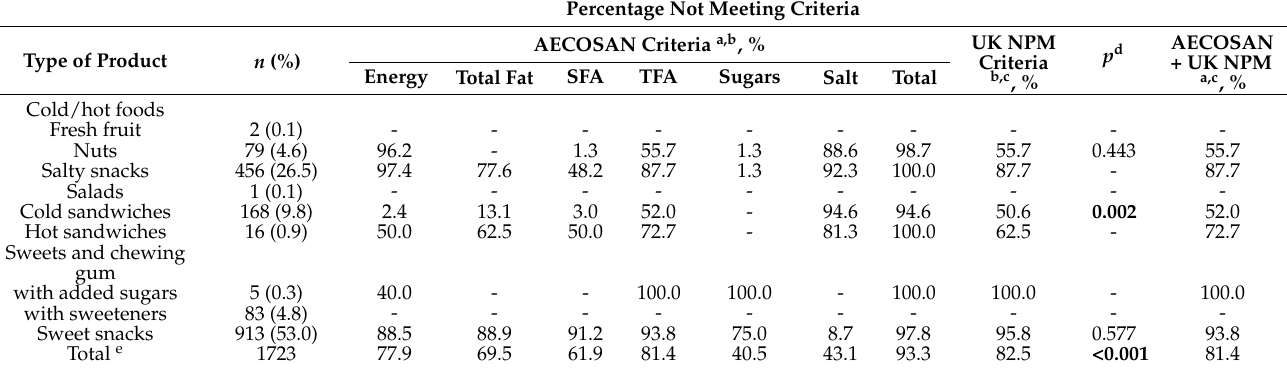
Table 4. Nutritional profiles of products offered in vending machines at the University of the Basque Country (Spain). Percentage Not Meeting Criteria Type of